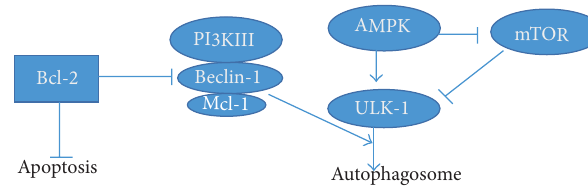
Figure 7: The Beclin-1 network regulates autophagy and apoptosis. DAHP and TP can attenuate cerebral ischemia through Beclin-1/Mcl-1 regulated autophagy pathways, which interacts with the apoptosis regulator